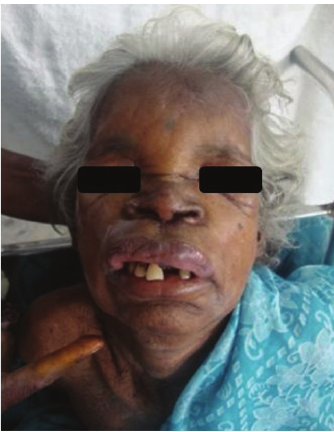
Figure 1: Extraoral photograph revealing diffuse swelling involving the upper lip and the anterior maxilla.